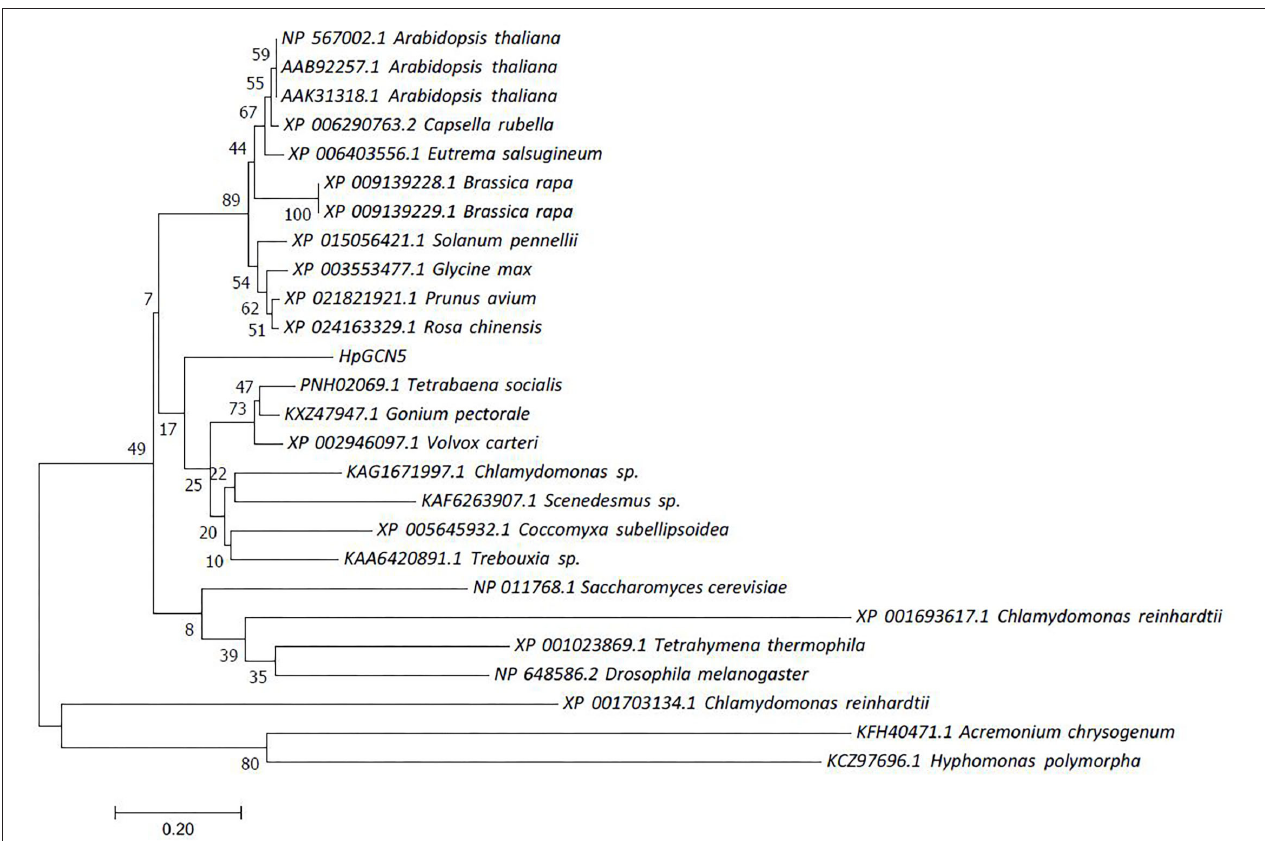
FIGURE 3 | Phylogenetic relationships of the deduced amino acids of HpGCN5 with its homologous from other